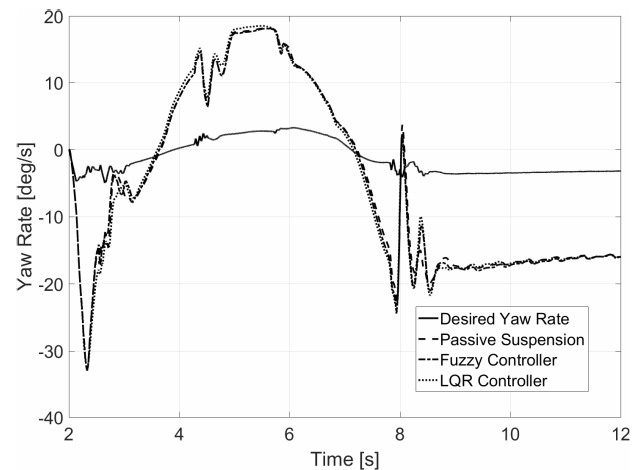
Figure 20. Yaw rate for Test